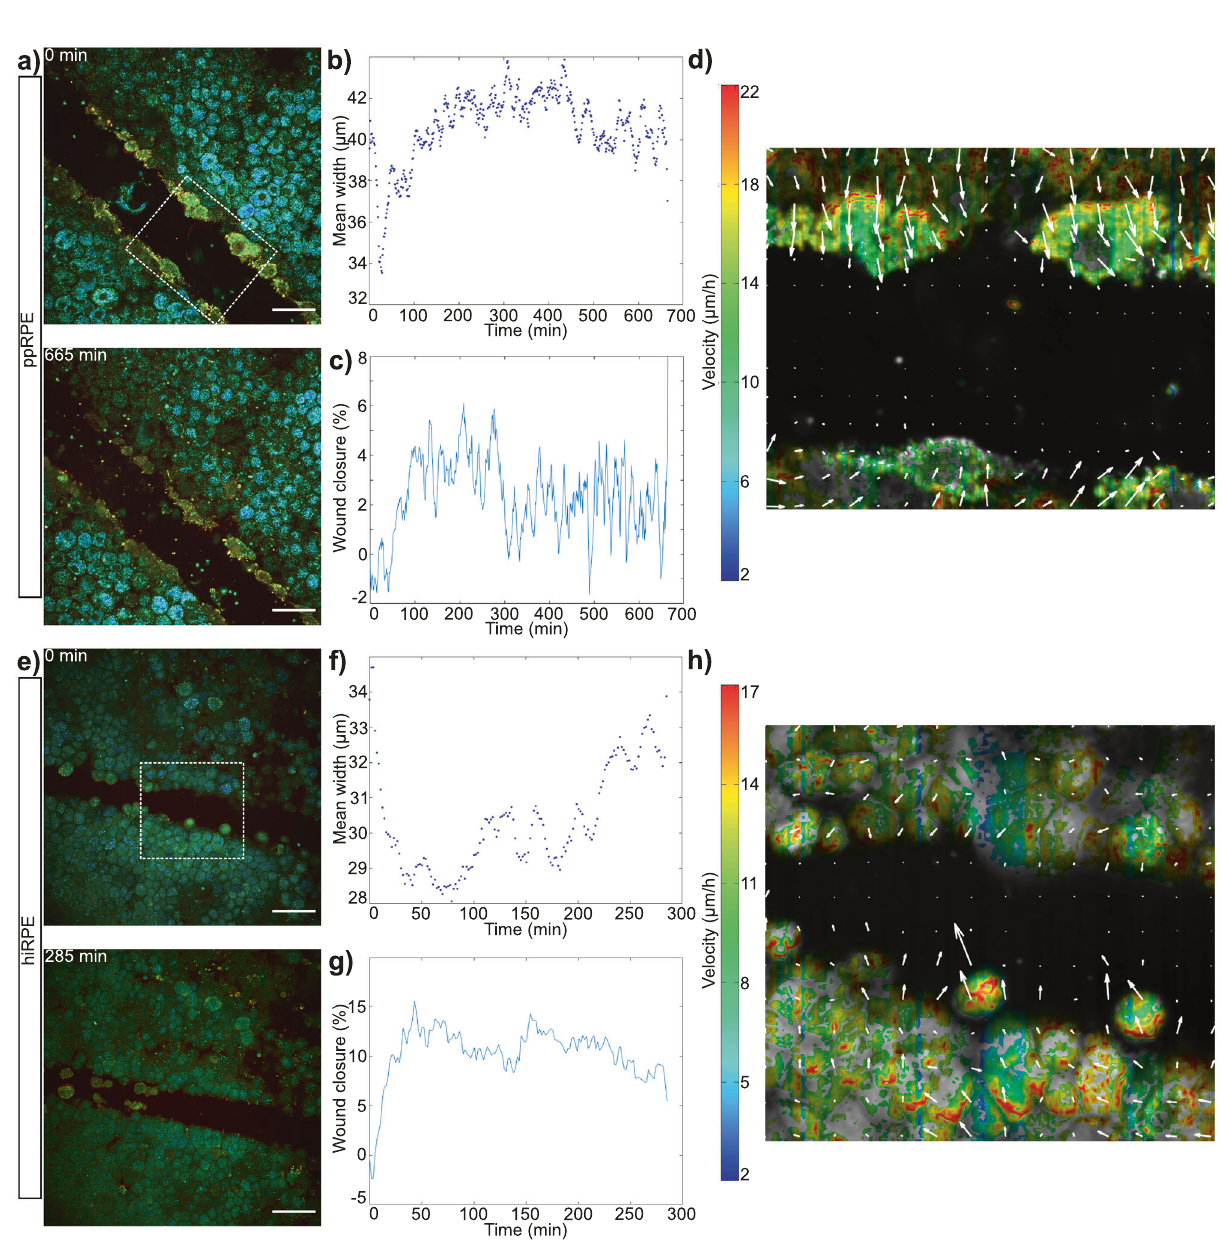
Fig. 2 Results on scratch assays (>25 μ m) on ppRPE and hiRPE cell cultures, failing to close entirely. a Beginning and end of the imaging of a scratch assay on ppRPE cell culture. b , c Evolution of scratch width and wound closure calculated with our programme and d optical fl ow calculations. e Beginning and end of the imaging of a scratch assay on hiRPE cell culture. f , g Evolution of the scratch width and wound closure, calculated with the SAVE pro fi ler and ( h ) optical fl ow calculations. (scale-bar: 50 μ m) (Statistics: see Supplementary Table